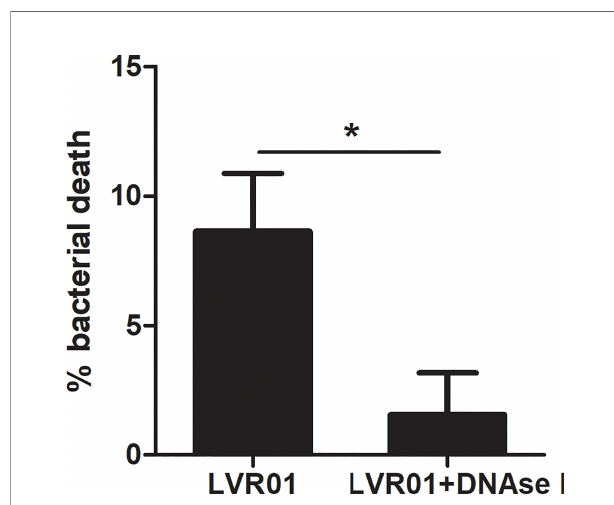
FIGURE 6 | Percentage of Salmonella death by METs. Salmonella was co- cultured for 60 minutes with J774A.1 cells, in presence or absence of DNAse I. Cells were lysed and bacteria counted. Results are shown as mean ± SD for each evaluated condition (n = 8). *p ≤ 0.05, Student T-test. One representative experiment of 4 independent ones performed.